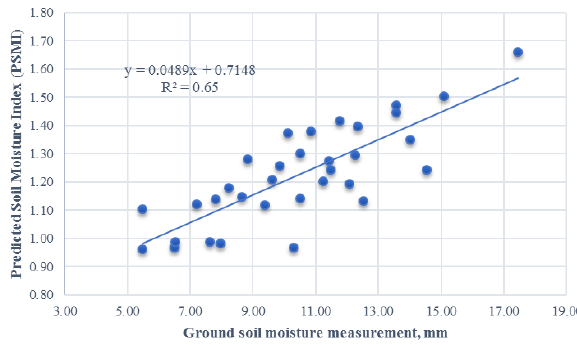
Figure 9. Relationship of ground soil moisture measurement and PSMI We used the Equation (8) for the estimation of kastanozems soil in the Table 5. This output was compared with ground truth data and shows moisture positive relation. In the table 5, the variables are described in detail. For instance, the soil moisture ground truth measurement, soil moisture index (SMI), normalized difference vegetation index (NDVI), land surface temperature (LST), elevation, aspect, slope and predicted soil moisture index